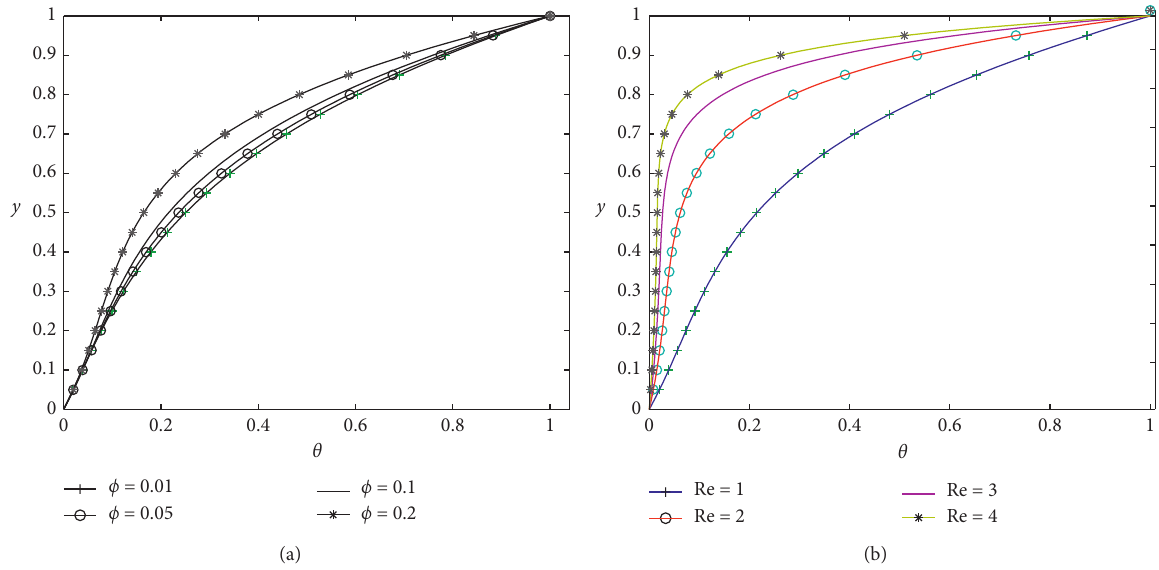
Figure 3: Temperature distribution for ε � 0 . 01 ,H � 3 , β � 2 , Ec � 0 . 1 , Da � 0 . 1 ,Q � 0 . 5 , Rd � 2 , M � 0 . 5 , Pr � 21 , and t � π /4. (a) Effect of ϕ when Re � 1. (b) Effect of Re when ϕ � 0 .